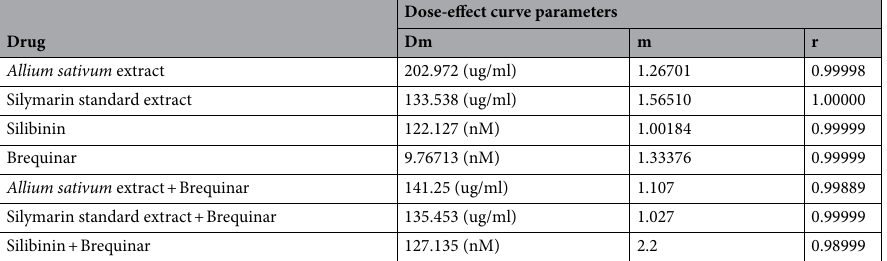
Table 4. Dose-effect curve parameters of Allium sativum extract, silymarin standard extract and silibinin individually and their binary combinations with brequinar. The boundaries Dm, m and r are the antilog of x-intercept, the slope and the linear correlation coefficient of the median-effect plot, respectively. CompuSyn was employed for automatic calculations.